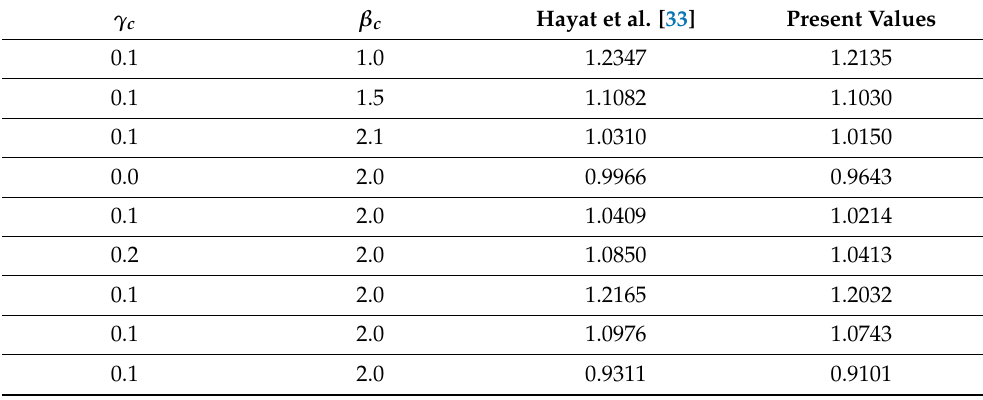
Table 12. Comparison of SFC with Hayat et al.